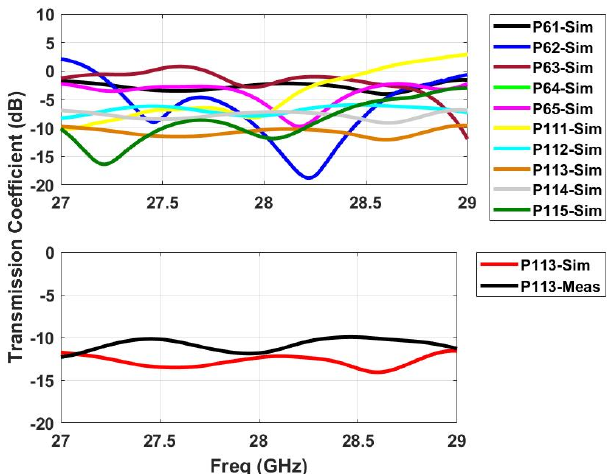
Figure 9. Simulated transmission coefficients ( top ) when ports 6 and 11 are active with measure-ment verification on a single port (P113) ( bottom ).